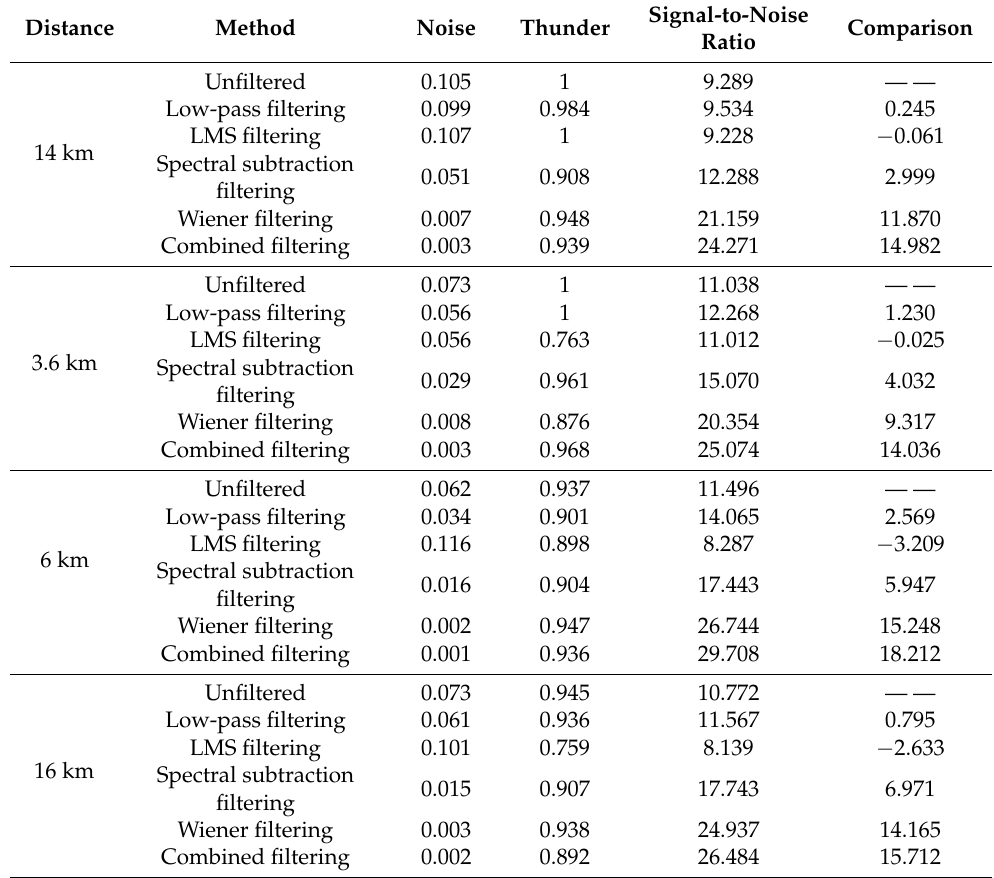
Table 1. Comparison of signal-to-noise ratios of the thunders filtered using different